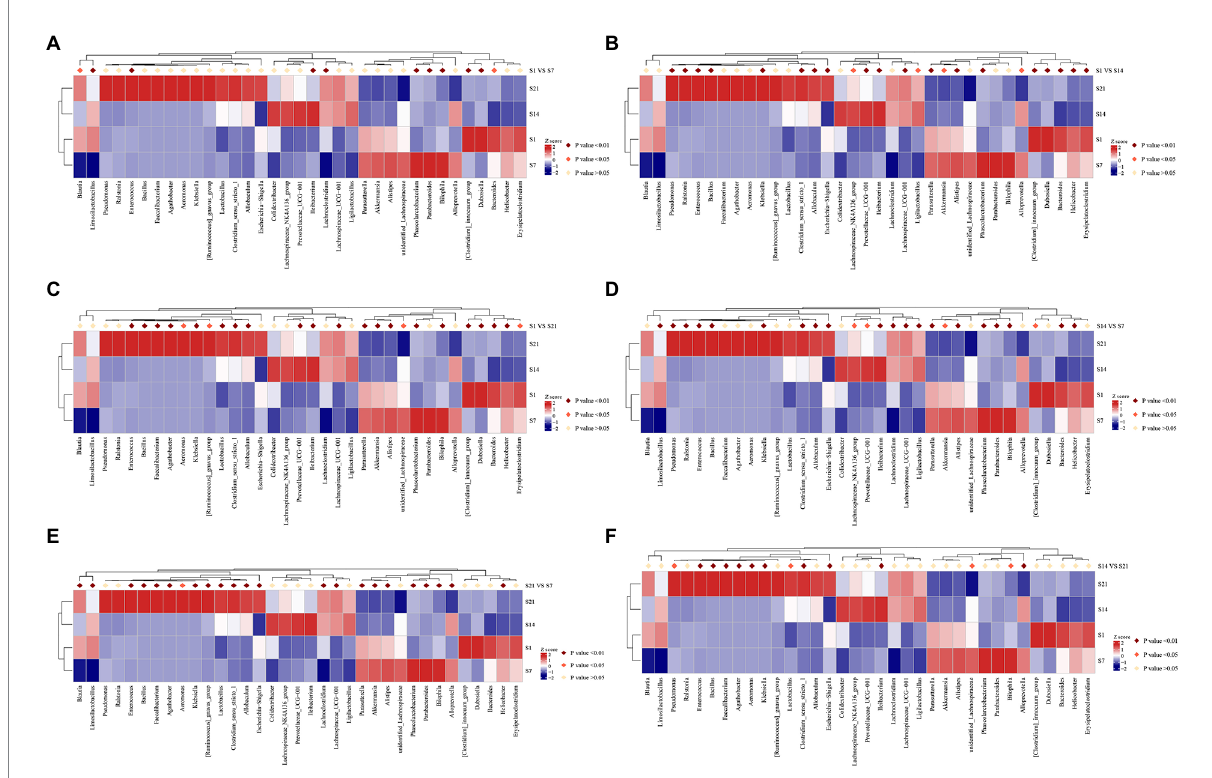
FIGURE 6 S1, day 1 of FMT; S7, day 7 of FMT; S14, day 14 of FMT; S21, day 21 of FMT; (A) S1 VS S7, Analysis of the intergroup differences on the day 1 and 7 of fecal microbiota transplantation; (B) S1 VS S14, Analysis of the intergroup differences on the day 1 and 14 of fecal microbiota transplantation; (C) S1 VS S21, Analysis of the intergroup differences on the day 1 and 21 of fecal microbiota transplantation; (D) S7 VS S14, Analysis of the intergroup differences on the day 7 and 14 of fecal microbiota transplantation; (E) S7 VS S21, Analysis of the intergroup differences on the day 7 and 21 of fecal microbiota transplantation; (F) S14 VS S21, Analysis of the intergroup differences on the day 14 and 21 of fecal microbiota transplantation. MetaStat analysis of the intergroup differences at the genus level of SPF mice. * p ≤ 0.05, ** p ≤ 0.01. SPF, specific pathogen